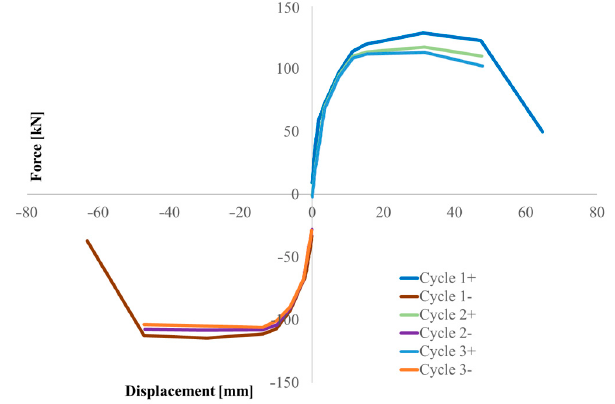
Figure 12. Horizontal force-peak displacements envelope diagram of the circular pier test.